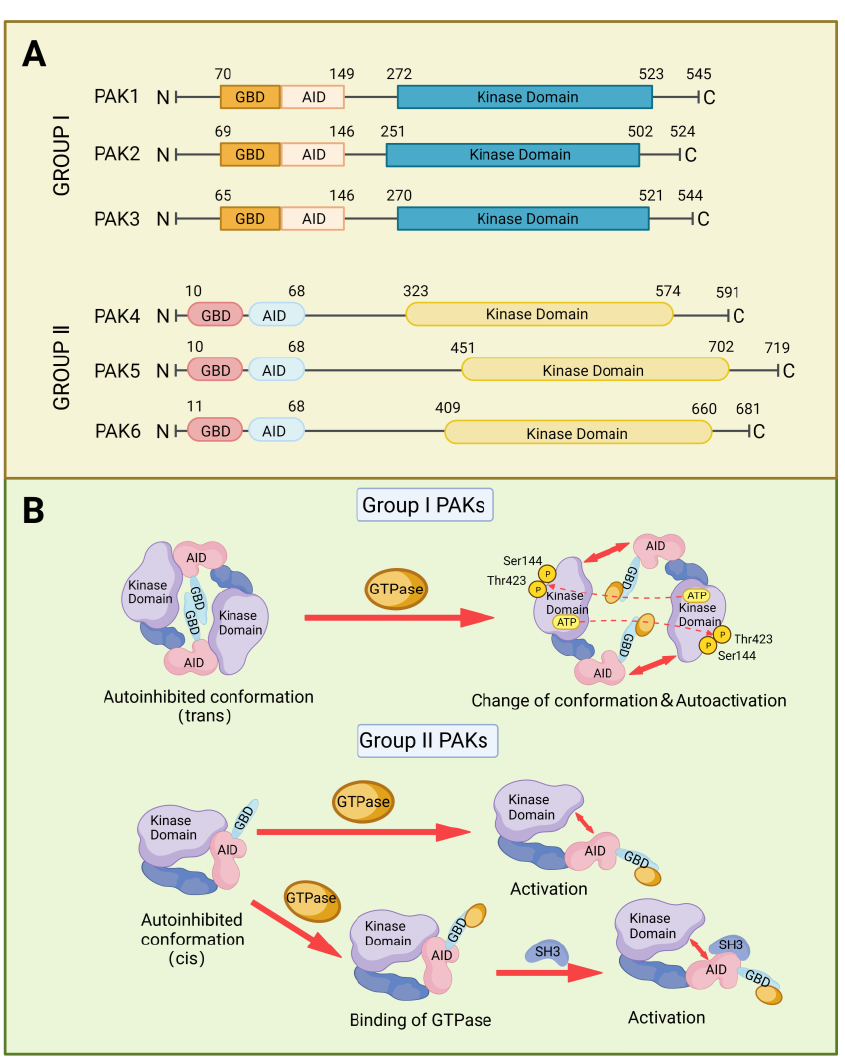
Figure 2. The structure and activation of PAKs. ( A ) Two-dimensional diagram of PAKs structure. ( B ) Different activation mechanisms of Group I PAKs and Group II PAKs.